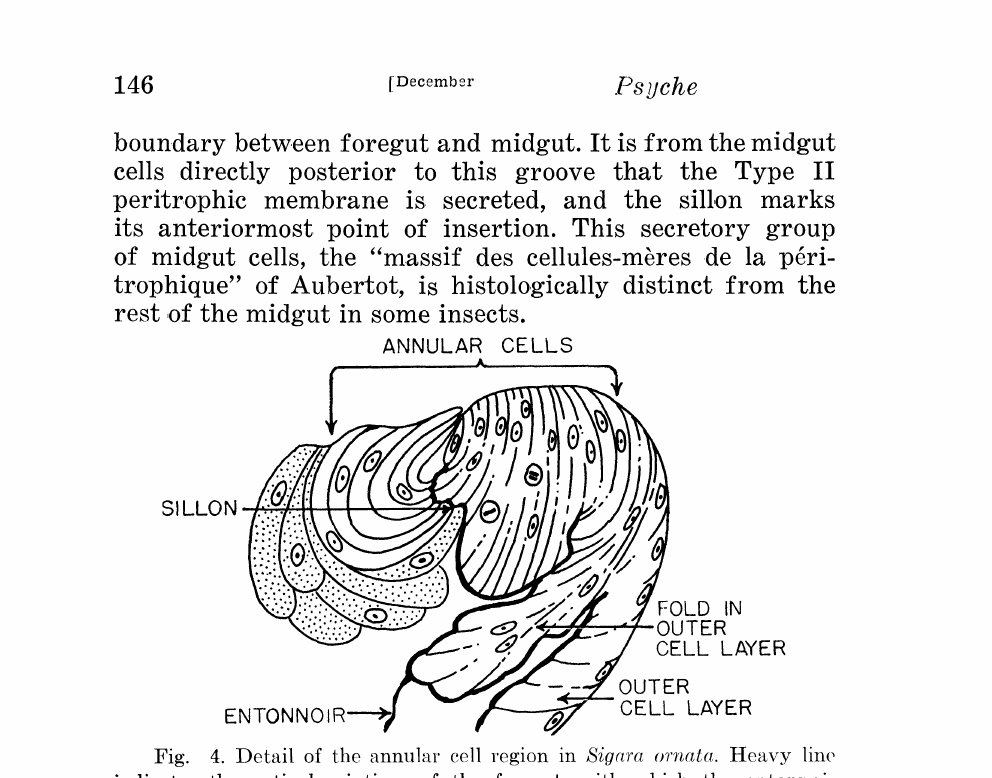
Fig. 4. Detail of the annular eel| region in Sigara ornata. Heavy line indicates the cuticular intim of the foregut, with which the entonnoir is continuous. Orientation sme as that of Figure B (Plate 12); the eso- phgus and inner cell lyer are not shown. The midgut epithelium is stippled. 850